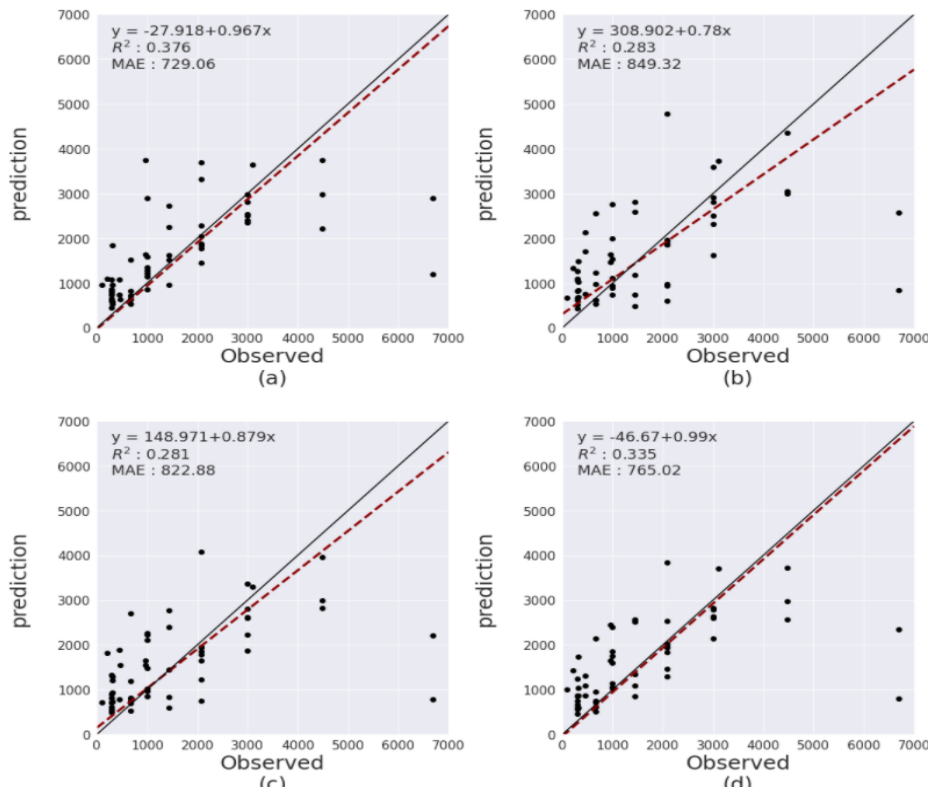
Figure 12. ( a ) Prediction result by (multivariate imputation using Bayesian ridge, standardization, Extra Tree, ( b ) Prediction result by (KNN Imputation, PCA, XGBoost), ( c ) Prediction result by (KNN Imputation, PCA, random forest), ( d ) Prediction result by average of the above three results.